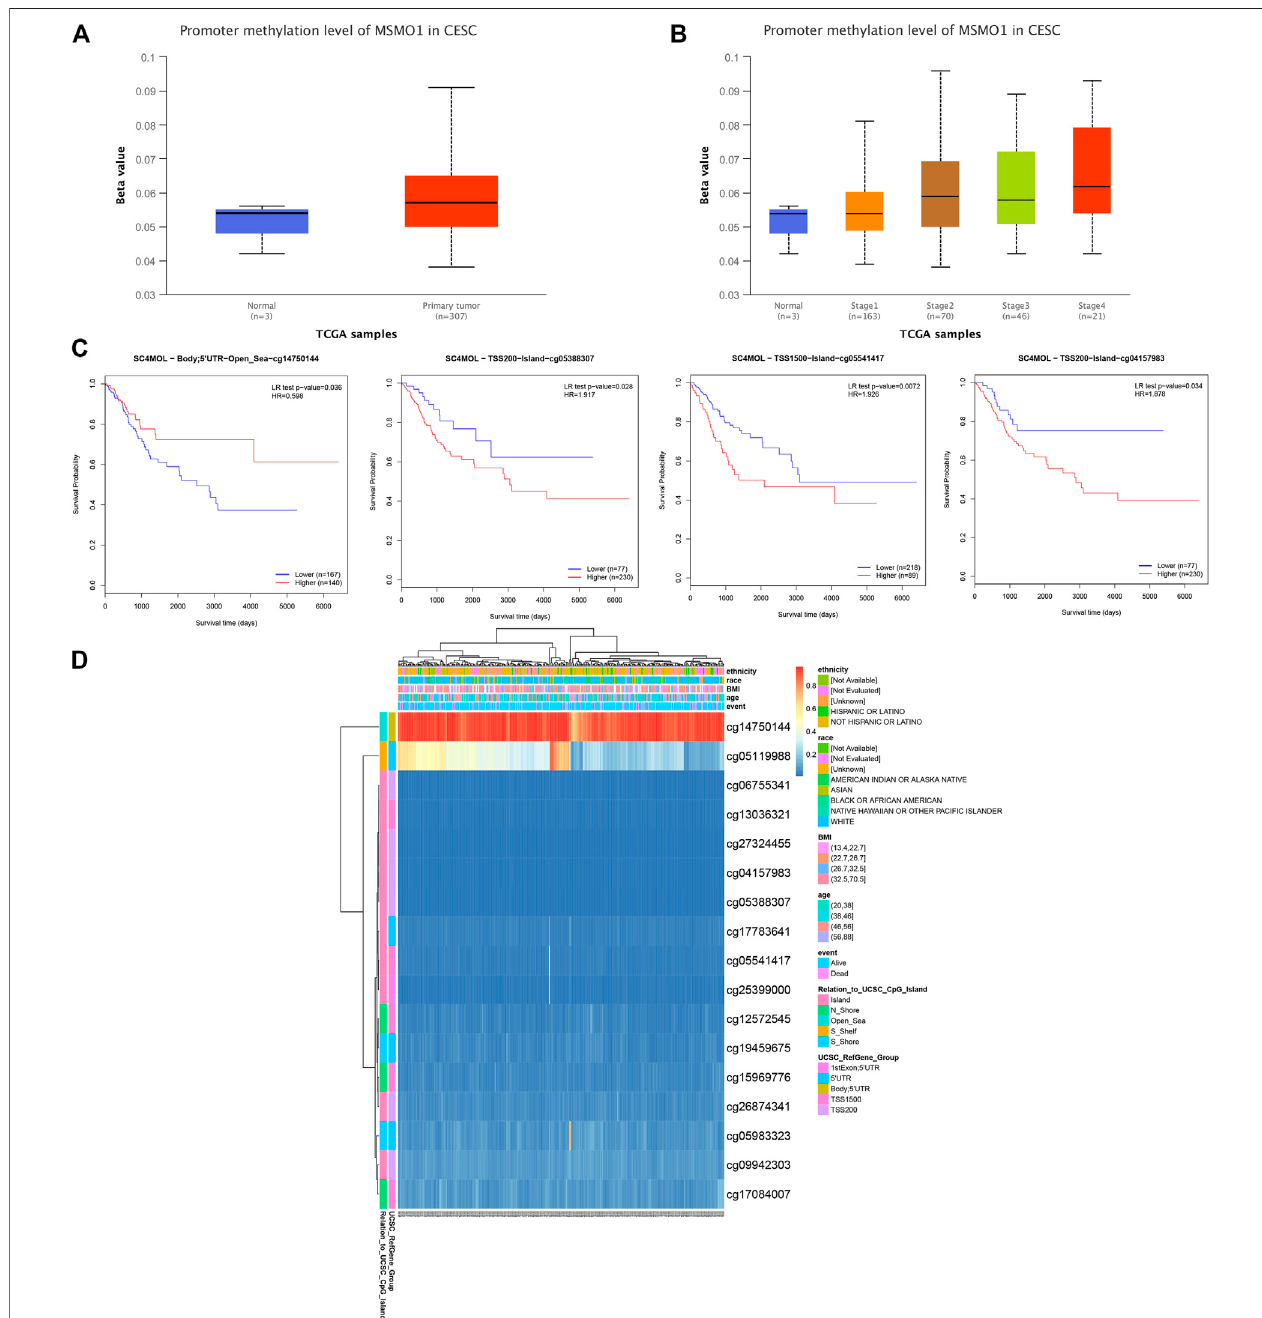
FIGURE10| Theclinical value of MSMO1 (SC4MOL) methylation. (A) The methylation status of genes in the normal group and the tumor group in theUALCAN database. (B) The relationship between gene methylation and clinical stage in the UALCAN database. (C) Different in the MethSurv tool Survival KM map of the basement region. (D) Heat map of MSMO1 (SC4MOL) methylation status related to different methylation regions in the MethSurv tool.